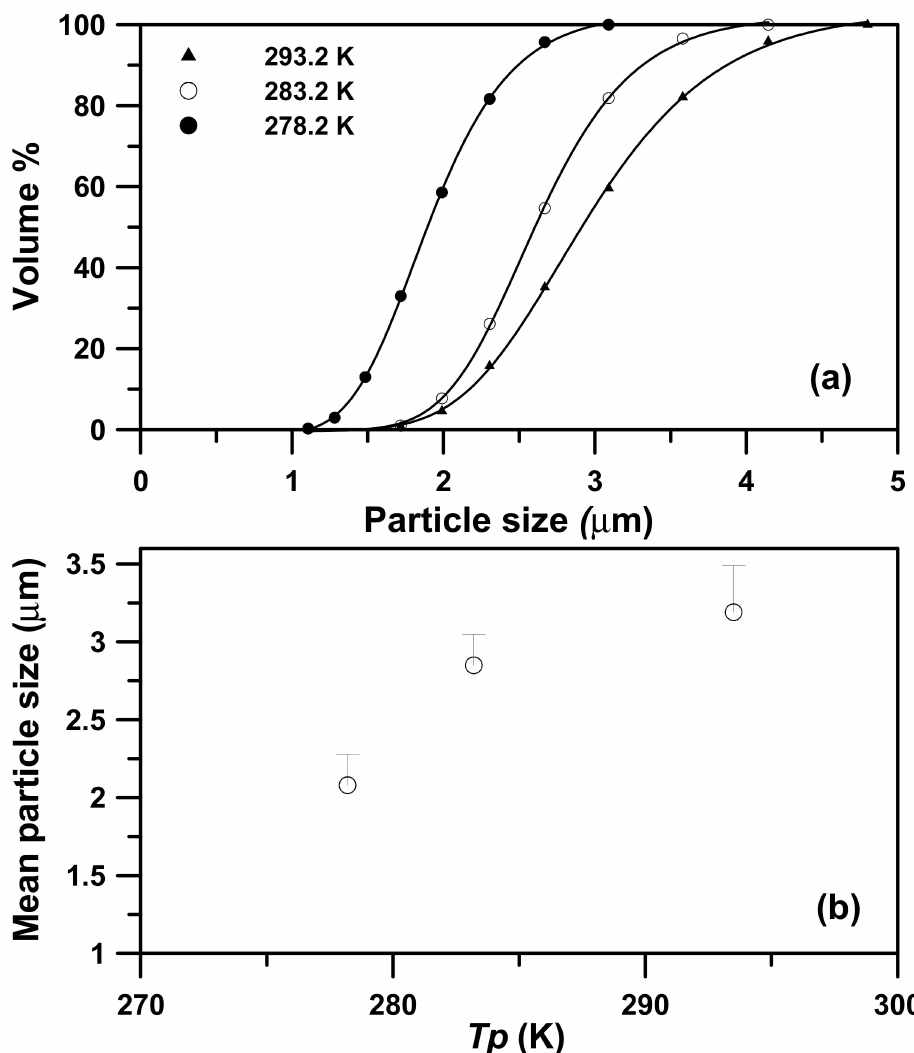
Figure 3. ( a ) The particle size distributions of the sample produced by the LTSAA process at di ff erent precipitator temperatures ( T P ), from 278.2 K to 293.2 K. ( b ) Mass-weighted mean particle size ( varying with precipitator temperature ( T P ) at C = 10 mg / mL, T S = 323.2 K, R = 2, and MW =